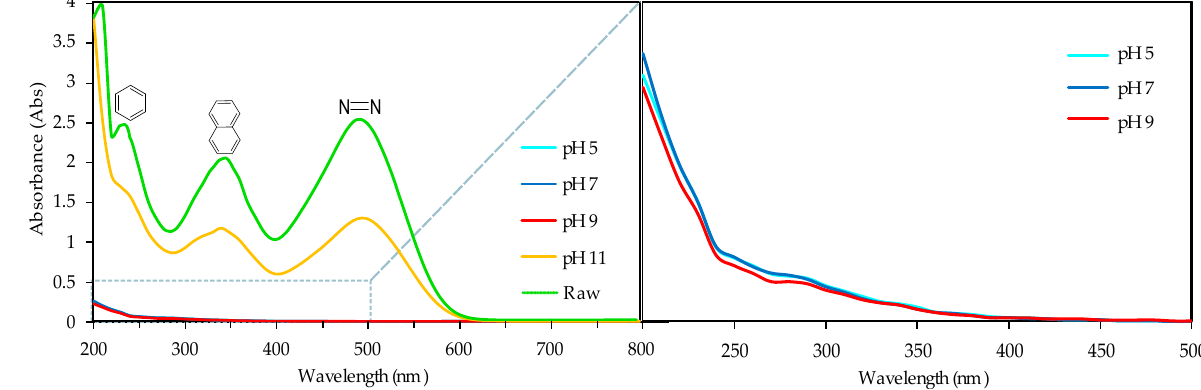
Figure 2. The UV–Vis spectra of diazo Congo red dye after the coagulation process at different initial pH values.